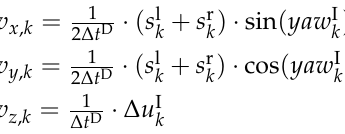
. The moving distance of the left and right wheels in t ) , yaw I where ( e DI , n DI , u DI and ∆ u I are the navigation coordinate, the yaw angle and the k k k k k height at time k in the DDE/INS r (